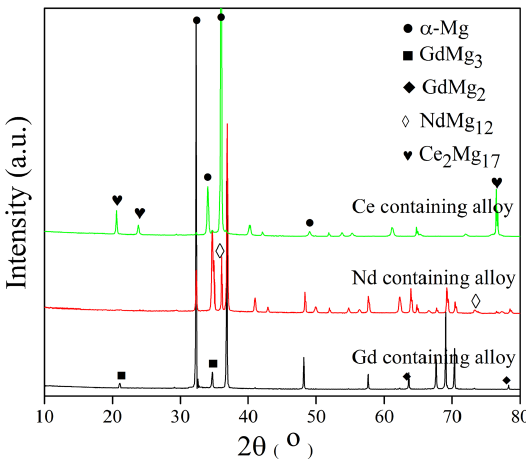
Figure 2. XRD patterns of RE-containing